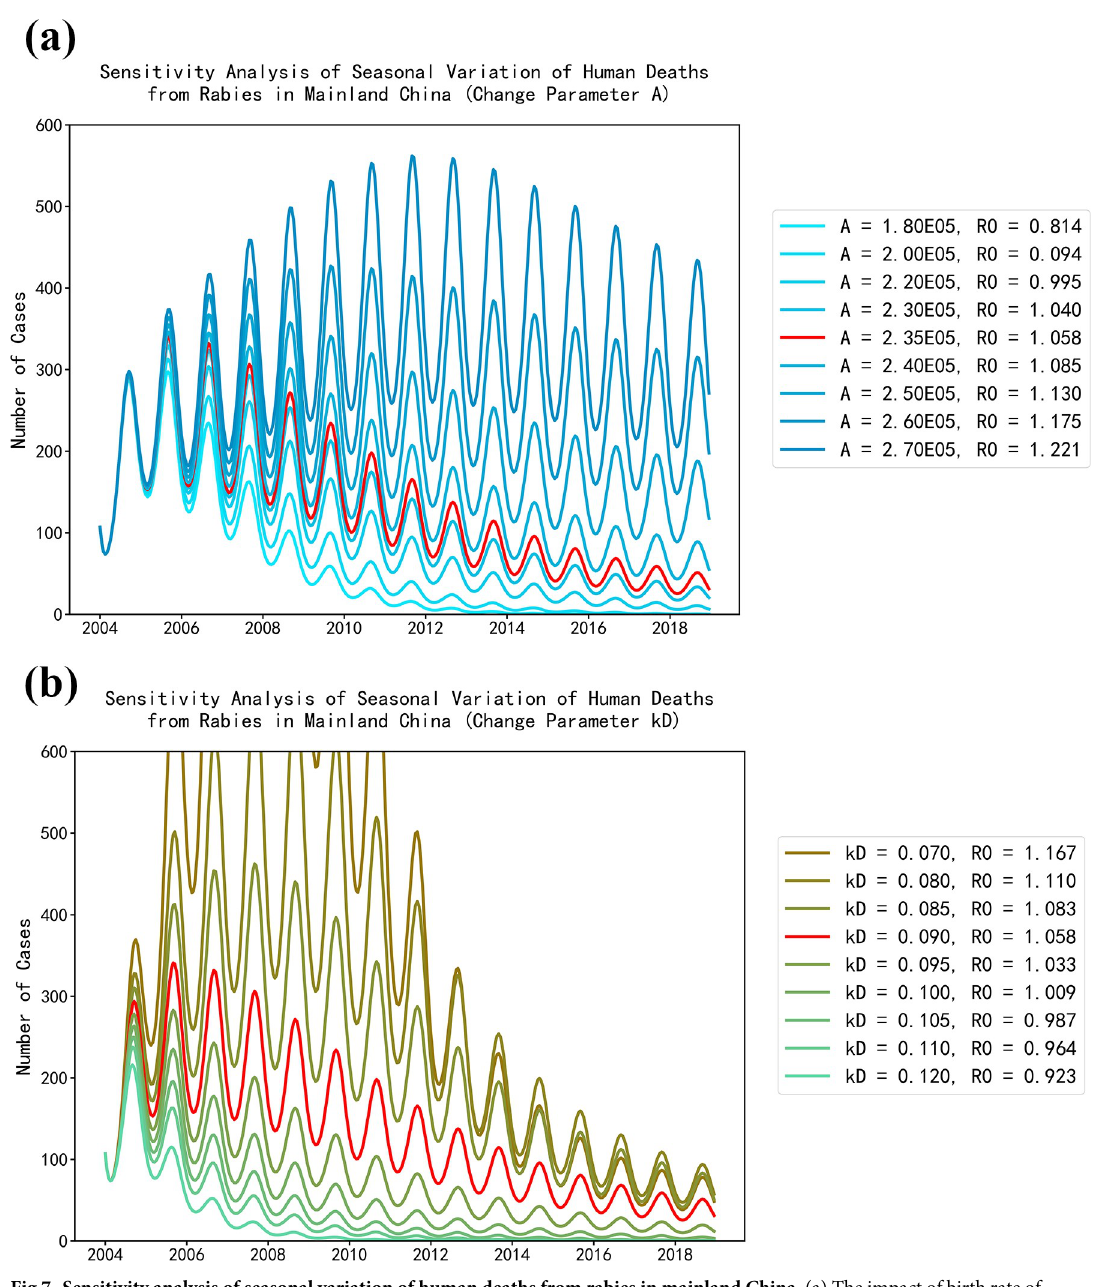
Fig 7. Sensitivity analysis of seasonal variation of human deaths from rabies in mainland China. (a) The impact of birth rate of canines. (b) The impact of vaccination rate of canines. data of human deaths from rabies, and the gradual blue curves represent the simulation results of human deaths from rabies by changing the birth rate of canines in the beginning of 2004. The legend illustrates the selected birth rates of canines and calculated basic reproduction numbers. We found the birth rate of canines had an important impact on the number of human deaths from rabies. The decline of the birth rate of canines significantly leads to the decrease of the number of human deaths from rabies. When the birth rate of canines decreased